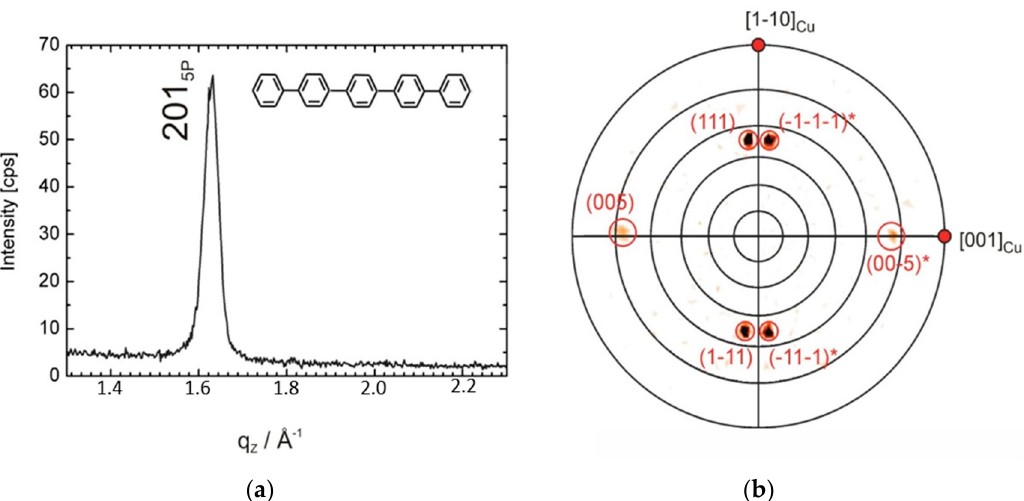
Figure 2. ( a ) X-ray diffraction (specular scan) of a 30-nm-thick quinquephenyl film grown on a Cu(110)-(2 × 1)O surface.; ( b ) pole figure taken at q = 1.4248 Å − 1 to find the spatial distribution of the 111 poles of the quinquephenyl crystals. Due to the finite resolution of the setup, 005 poles are also visible. Additionally, two directions on the substrate surface are given: [1–10] Cu and [001] Cu . The inset in ( a ) shows the chemical structure of the molecule quinquephenyl.